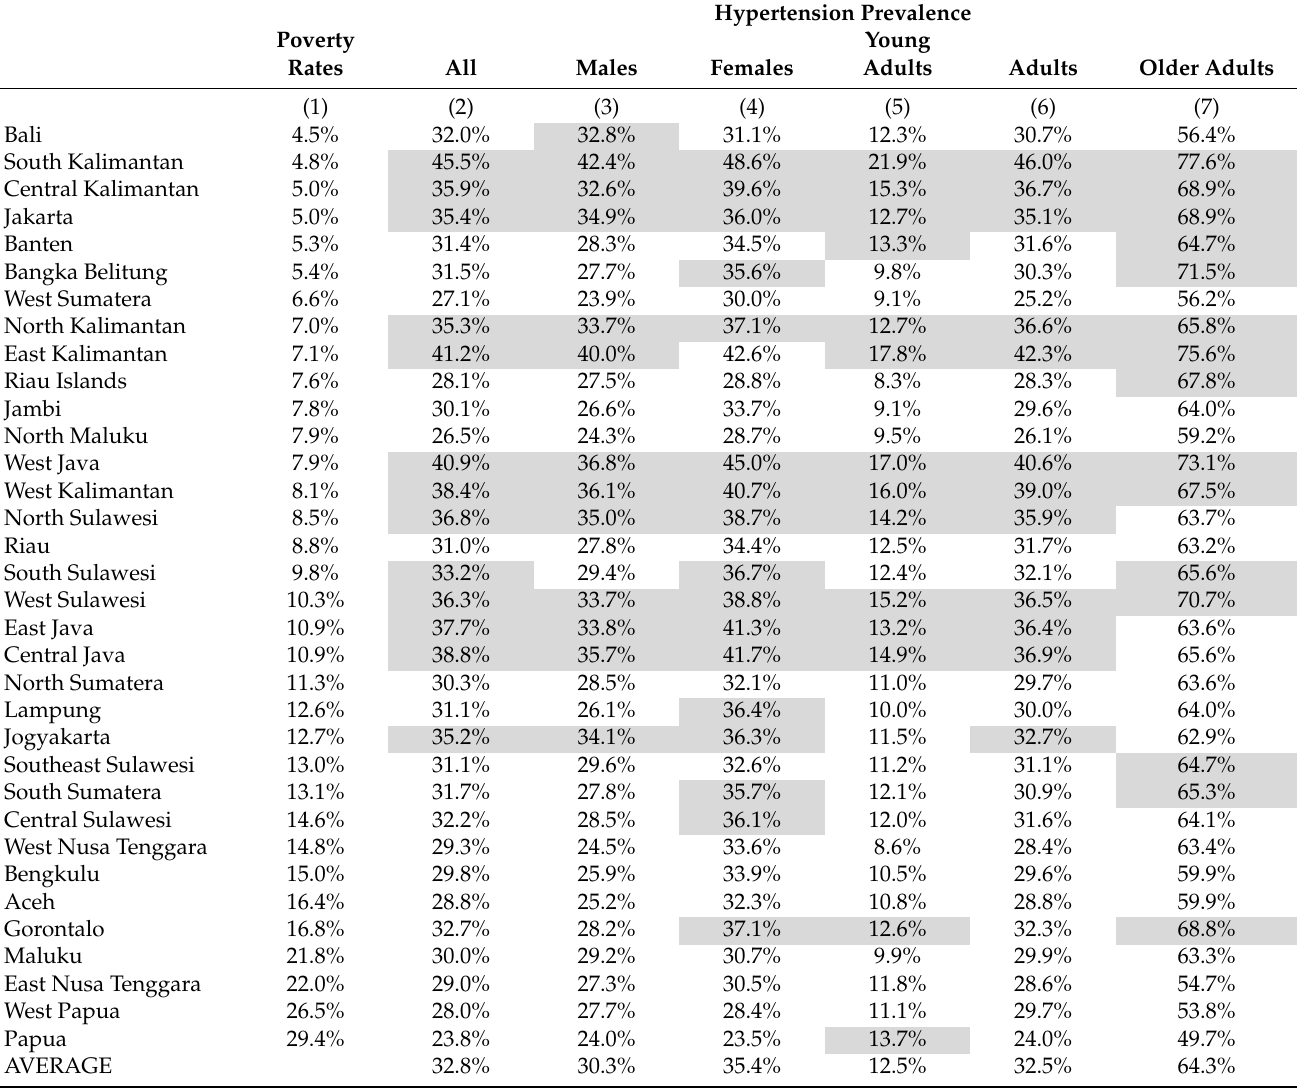
Table 1. Prevalence of hypertension among adults by province in Indonesia,